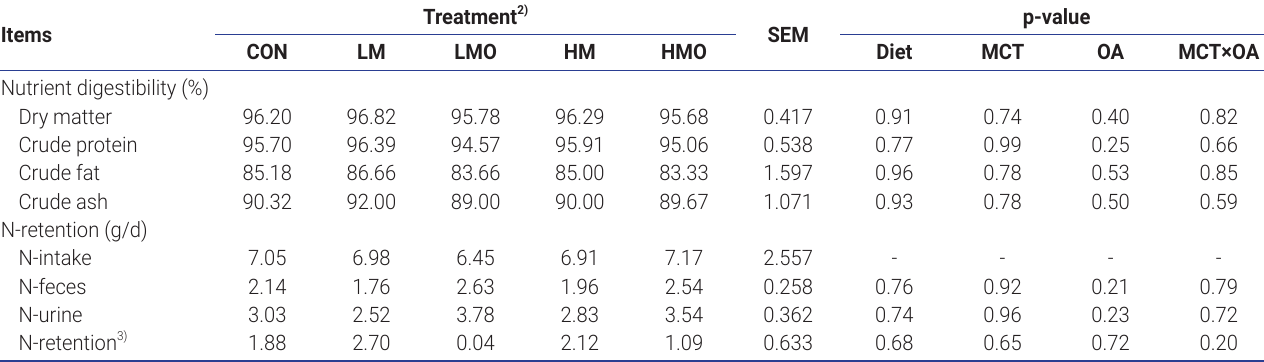
Table 7. Effects of medium chain triglycerides and organic acids on nutrient digestibility in weaning pigs